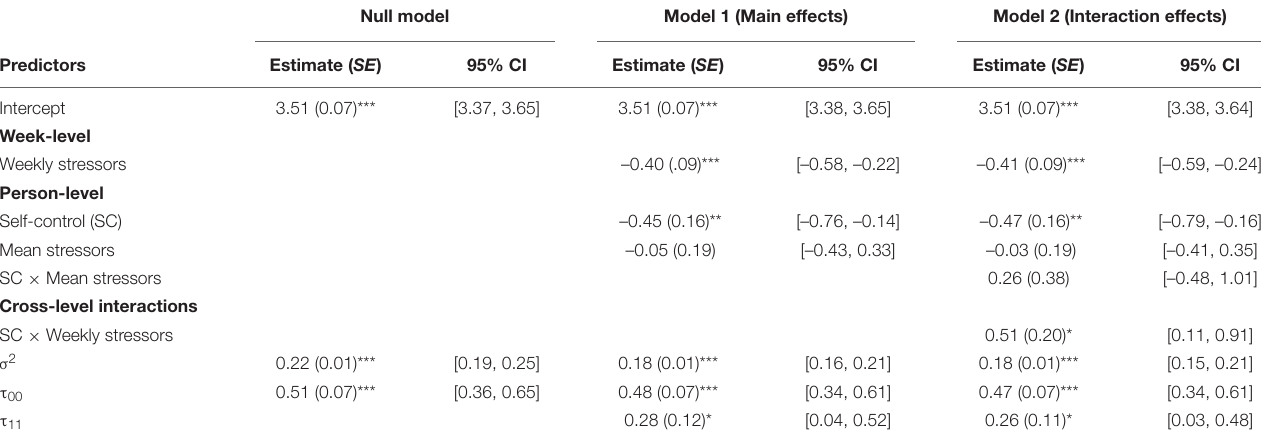
TABLE 2 | Unstandardized coefficients from multilevel linear models of cyberloafing and affect.